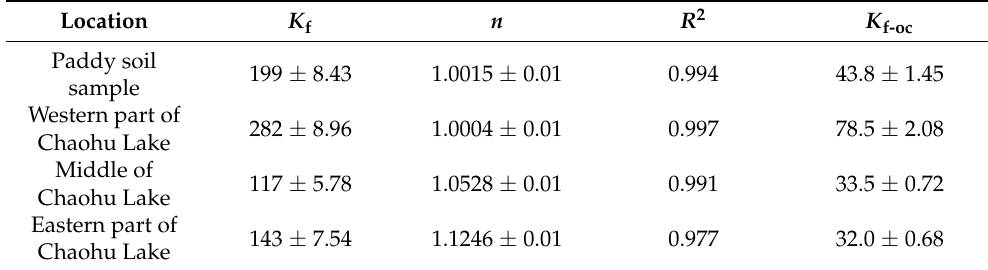
Table 3. Freundlich model parameters of 2,3,7,8-TCDT in sediments and paddy soil.